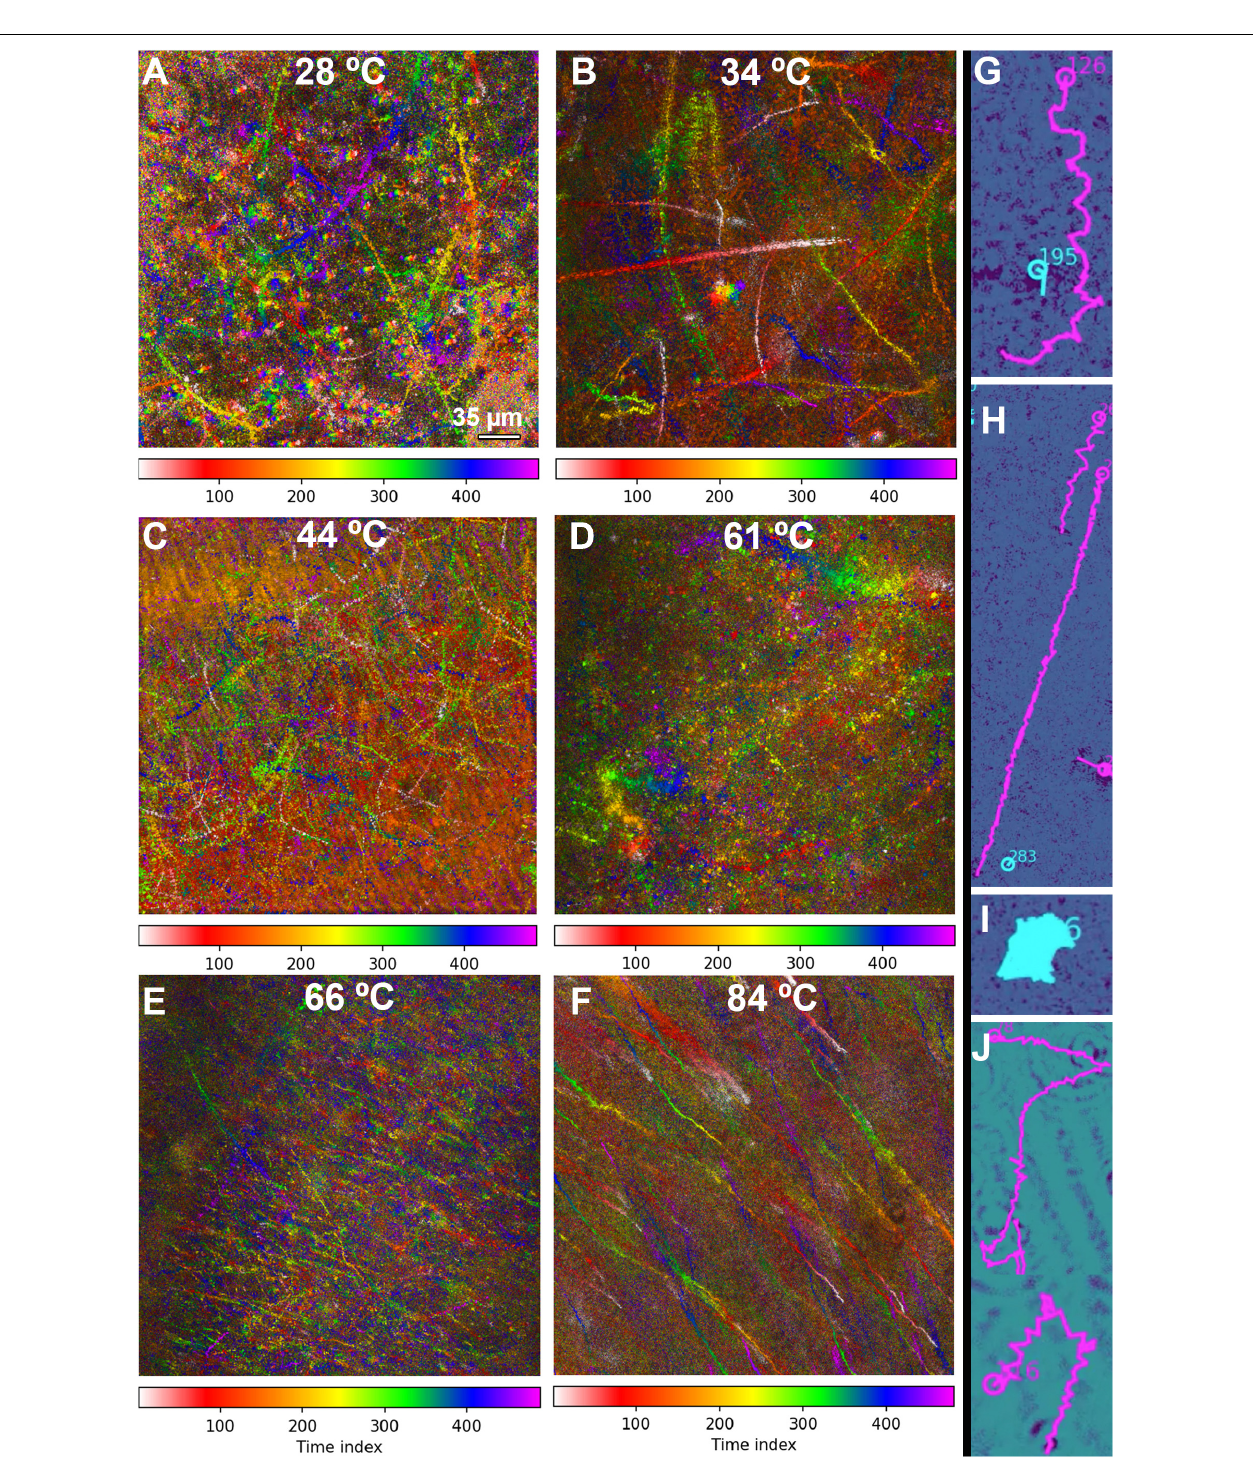
FIGURE 6 | MHI analysis shows changes in motility patterns with increasing temperature and assists in identifying motile tracks. The tracks are time-coded, with the time index indicating frame number (15 frames/s). The scale bar applies to all panels. (A–F) Full field of view of all identified tracks in selected datasets. (A) 28 ◦ C, showing a distribution of motile and non-motile cells and distinct swimming patterns. (B) 34 ◦ C, showing increased motility and speed. (C) 44 ◦ C, showing nearly all cells motile at high speed. (D) 61 ◦ C, showing a reduction in the number of motile cells, but some swimming at high speed. (E) 66 ◦ C, showing a large amount of thermal drift with a few motile cells. (F) 84 ◦ C, with all motion due to thermal drift. (G–J) Selected examples of swimming types identified in the tracks. Magenta indicates tracks identified as motile by the software; tracks in cyan were identified as non-motile. (G) Helical swimming. (H) Long straight runs. (I) Circling or spinning. (J) Run and